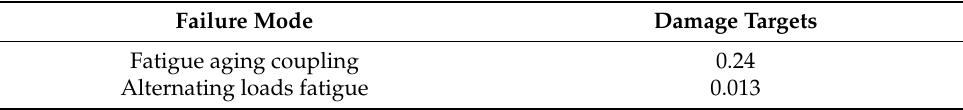
Table 4. Damage targets under different failure modes.